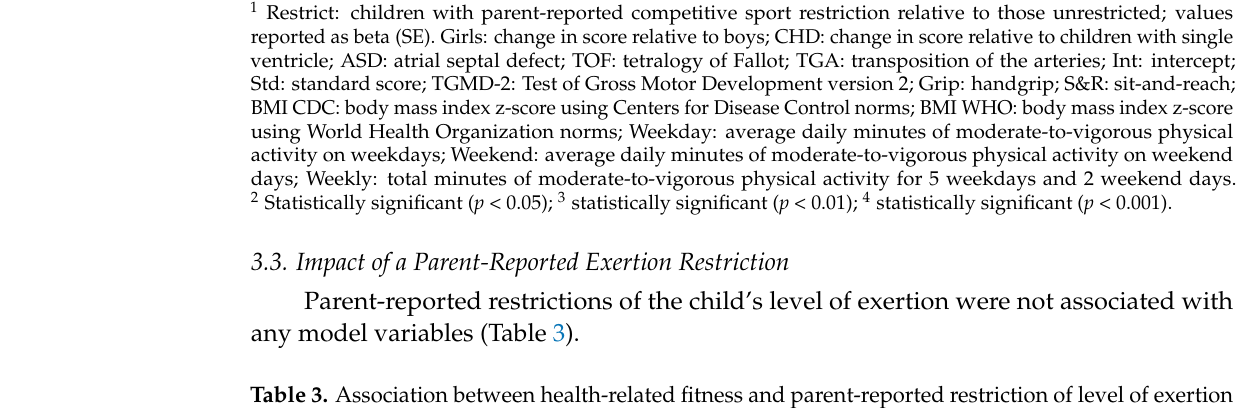
Table 3. Association between health-related fitness and parent-reported restriction of level of exertion among children with CHD, adjusting for sex, age, and type of